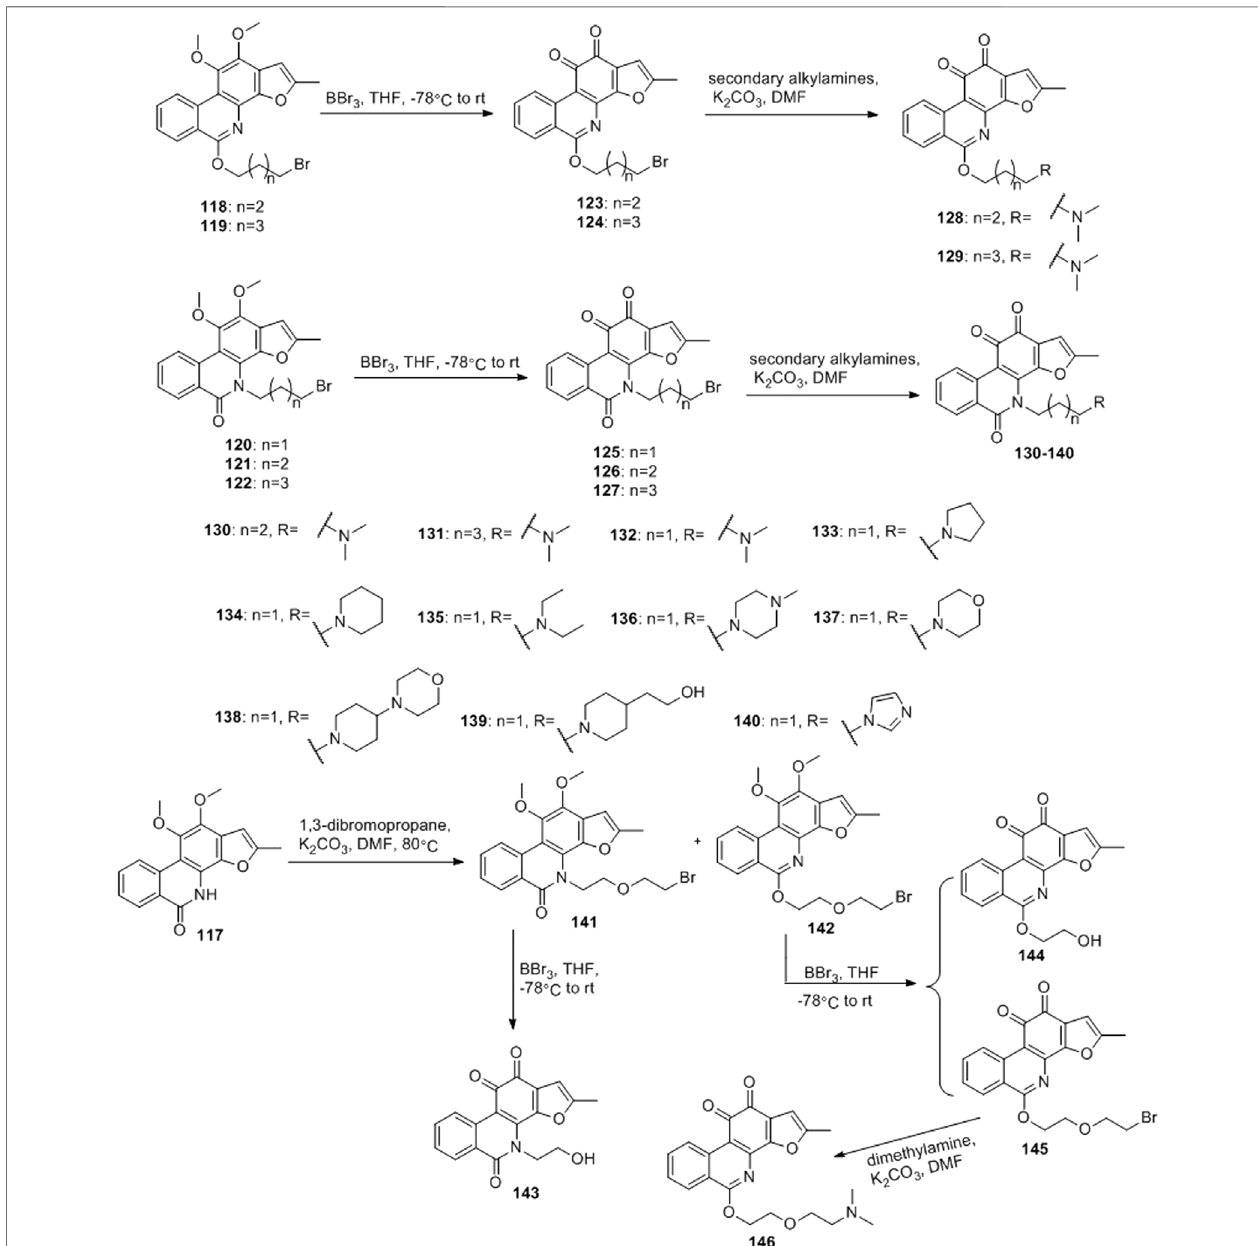
FIGURE 15 | Anchor the side chain on the N- or O-